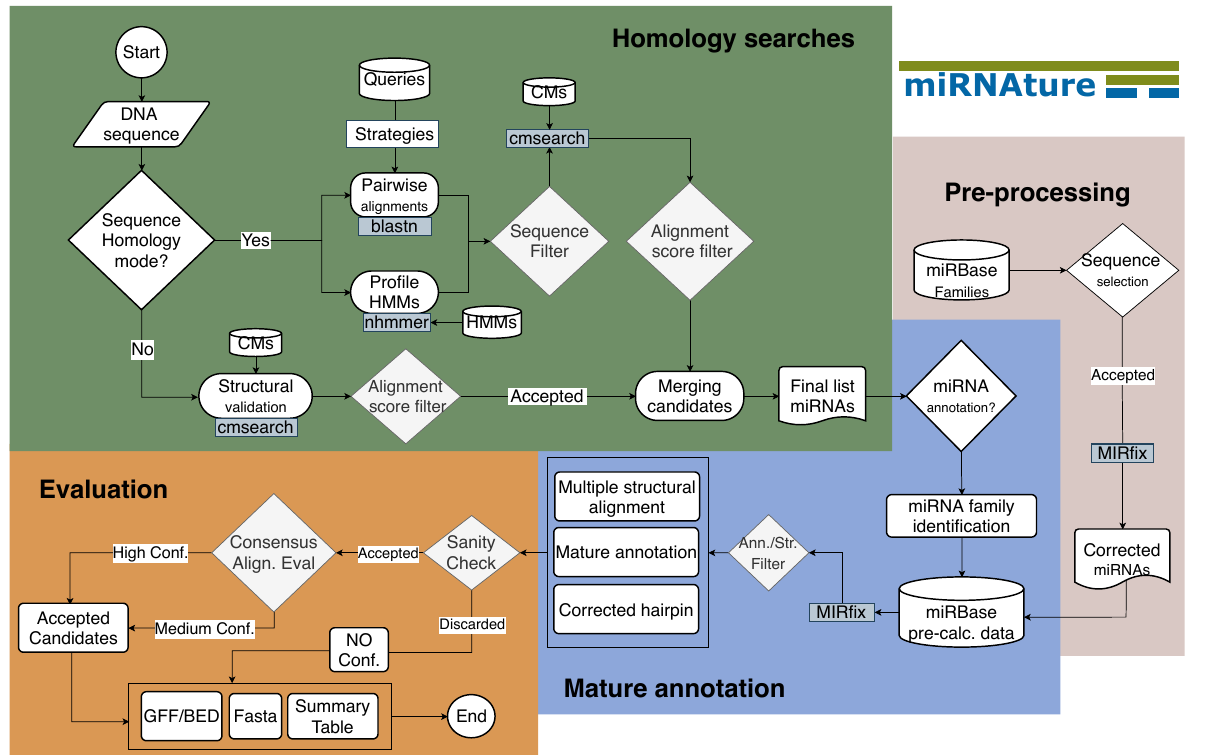
Figure 1. Workflow of miRNAture . The starting point is the provided set of target sequence by the user, which is first analyzed in Homology search mode to detect miRNA candidates. Specifically, two strategies are available: sequence homology and structural validation. The first one using pairwise alignments, performed with blastn , or hidden markov models (HMMs) using nhmmer . The second one is based on the use of covariance models (CMs). Each of the described stages has their own filters, accepted candidates being submitted to the next stage while discarded candidates are reported separately for later manual inspection. A merging step produces a final list of homology candidates. After that, Mature annotation stage runs on these input sequences and performs a correction of the positioning of mature sequences on the hairpin, generating a correctly anchored family-specific-multiple secondary structure alignment (calculated by MIRfix [19]). The Evaluation stage starts with a sanity check that reviews the mature annotation and performs a comparison of conserved secondary structures with and without the newly annotated candidates. Based on this classification the candidates will be labeled as accepted or discarded. Sequence length and minimum free energy (MFE) cutoffs are used for further filtering. A final set of candidates is reported in BED/GFF3 annotation formats and FASTA files. A summary file provides overall information about the miRNA candidates and families and contains additional candidates which failed or have not been considered for evaluation due to cutoffs for manual